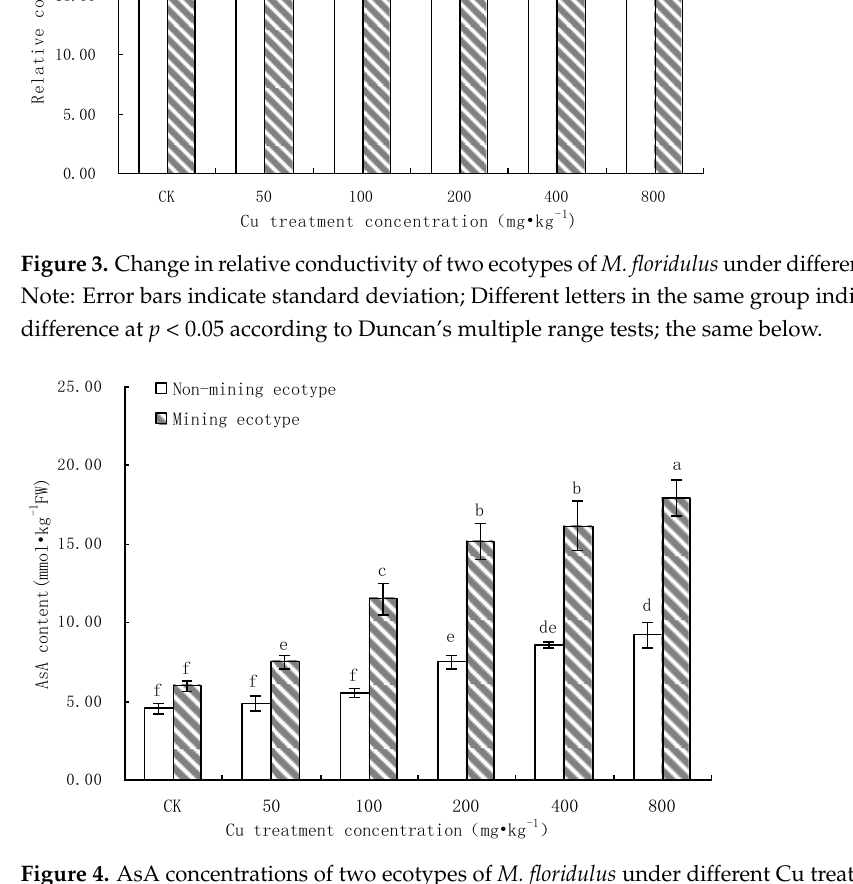
Figure 3. Change in relative conductivity of two ecotypes of M. floridulus under different Cu treat- ment. Note: Error bars indicate standard deviation; Different letters in the same group indicate sig- nificant difference at p < 0.05 according to Duncan’s multiple range tests; the same below.